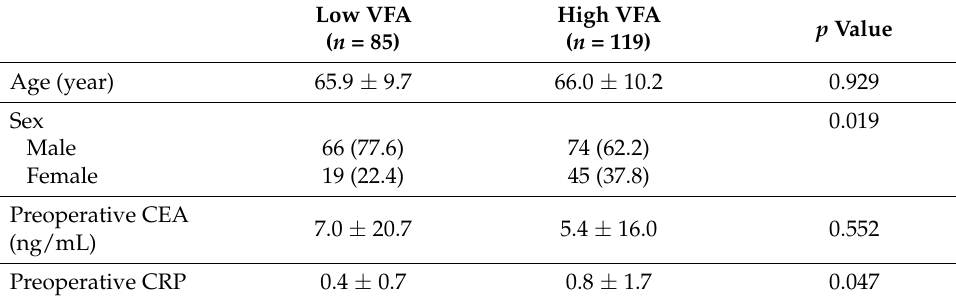
Table 1. Patient and Tumor